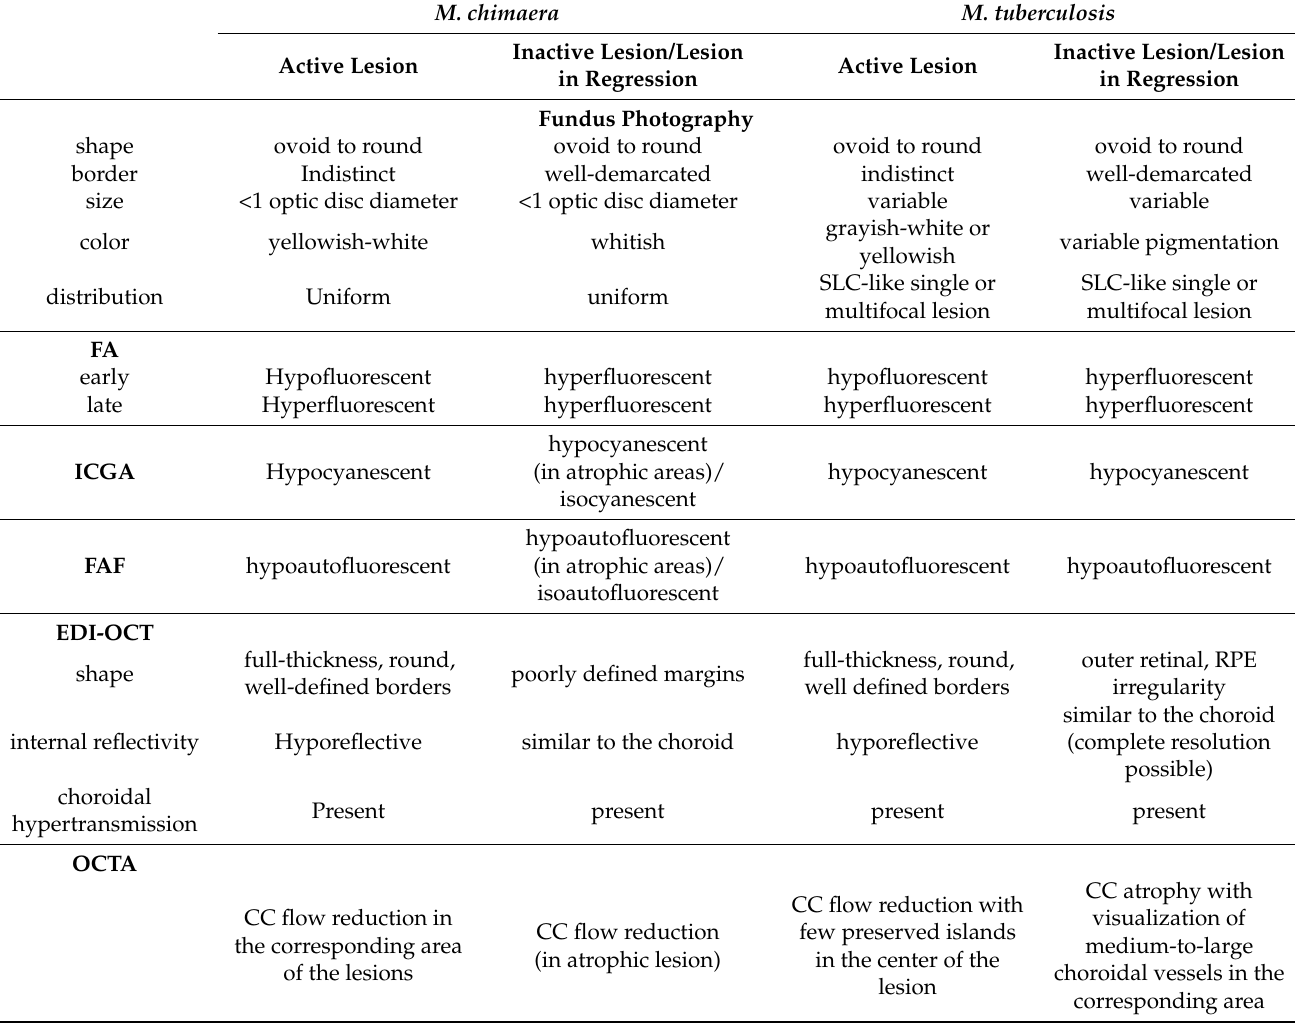
Table 1. Classification and comparison of choroidal lesions due to M. tuberculosis and M. chimaera based on multimodal